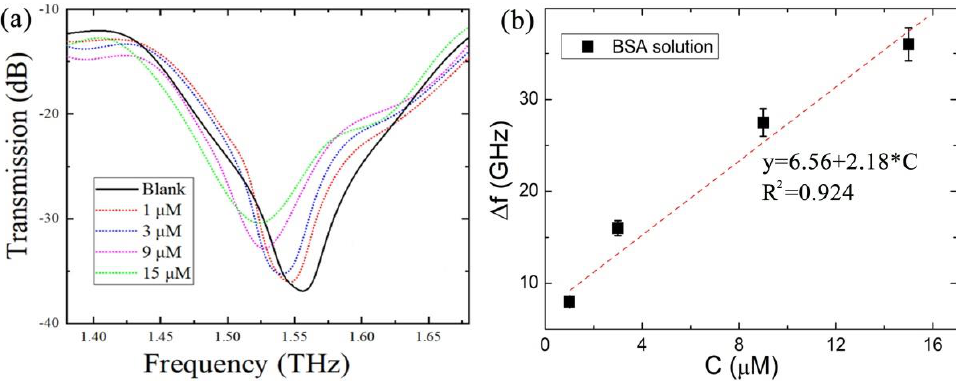
Figure 5. ( a ) Transmission spectra of the blank sensor and sensor covered by BSA sample at different concentrations. ( b ) Relationship between ∆ f and the BSA concentration with the dash line being the fitting line.